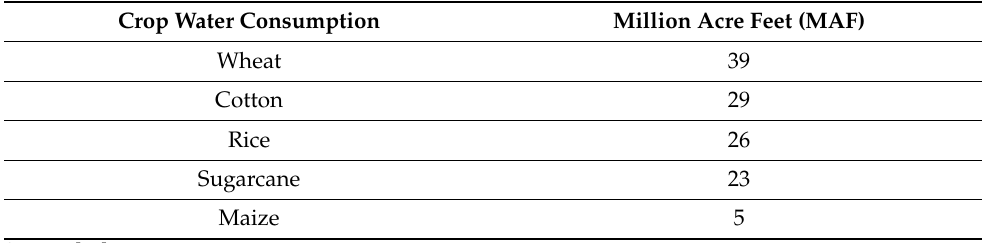
Table 2. Current water consumption by five major crops.